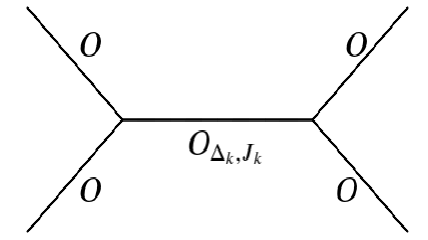
Figure 5 . Schematic for the conformal block